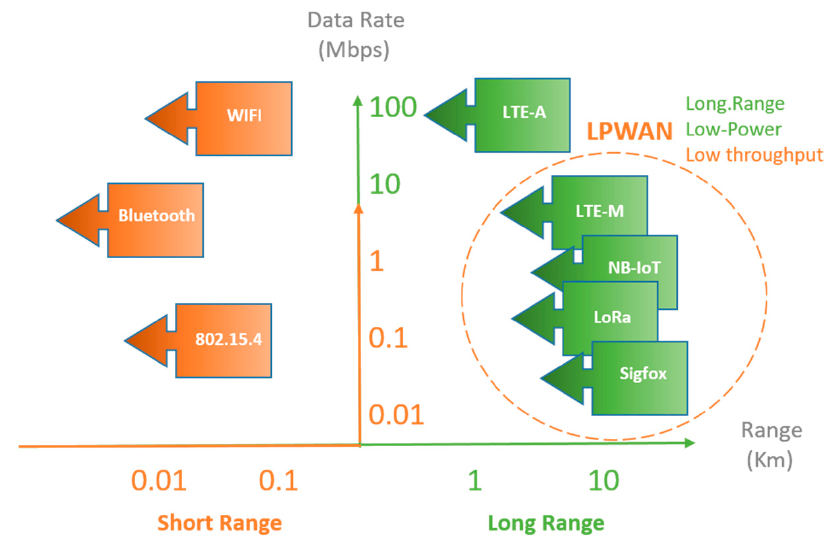
Figure 1. Comparison between Low Power Wide Area Network (LPWA) networks and other connectivity technologies.